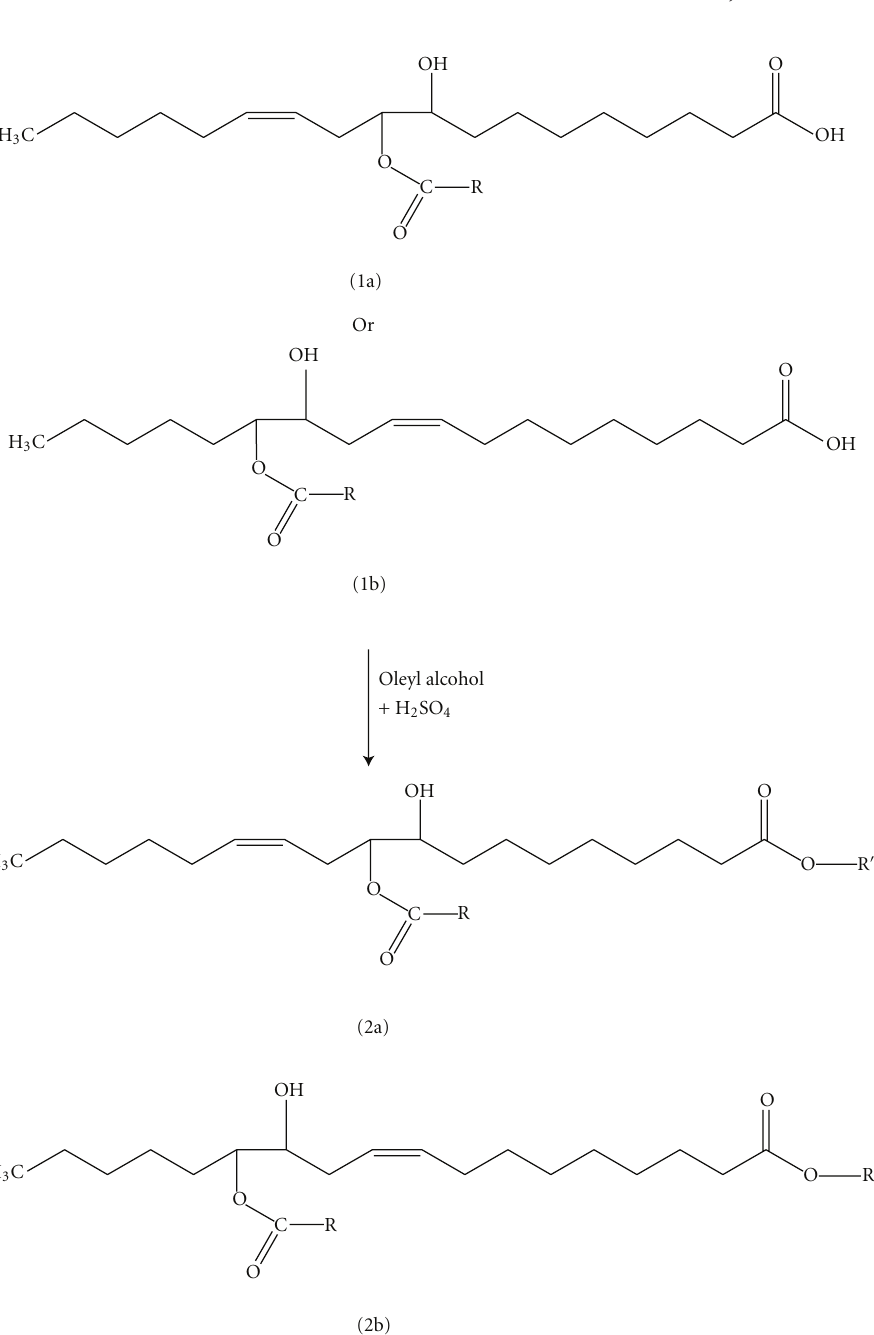
Figure 1: Esterification reaction of HYOOA to produce OLHYOOD. Notes: 9-hydroxy-10-oleioxy-12-octadecanoic acid (1a); 12-hydroxy- 13-oleioxy-9-octadecanoic acid (2a); oleyl 9-hydroxy-10-oleioxy-12-octadecanoate (1b); oleyl 12-hydroxy-13-oleioxy-9-octadecanoate (2b); oleic acid (R) and oleyl alcohol (R (cid:3)